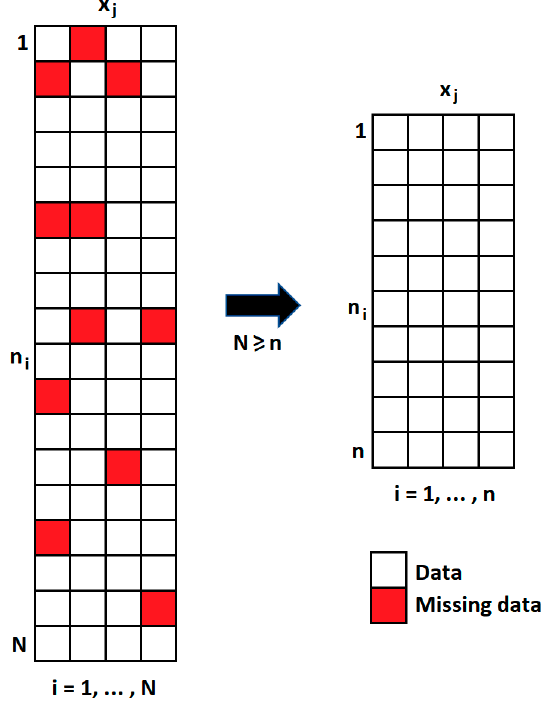
Figure 2. Purging missing values.